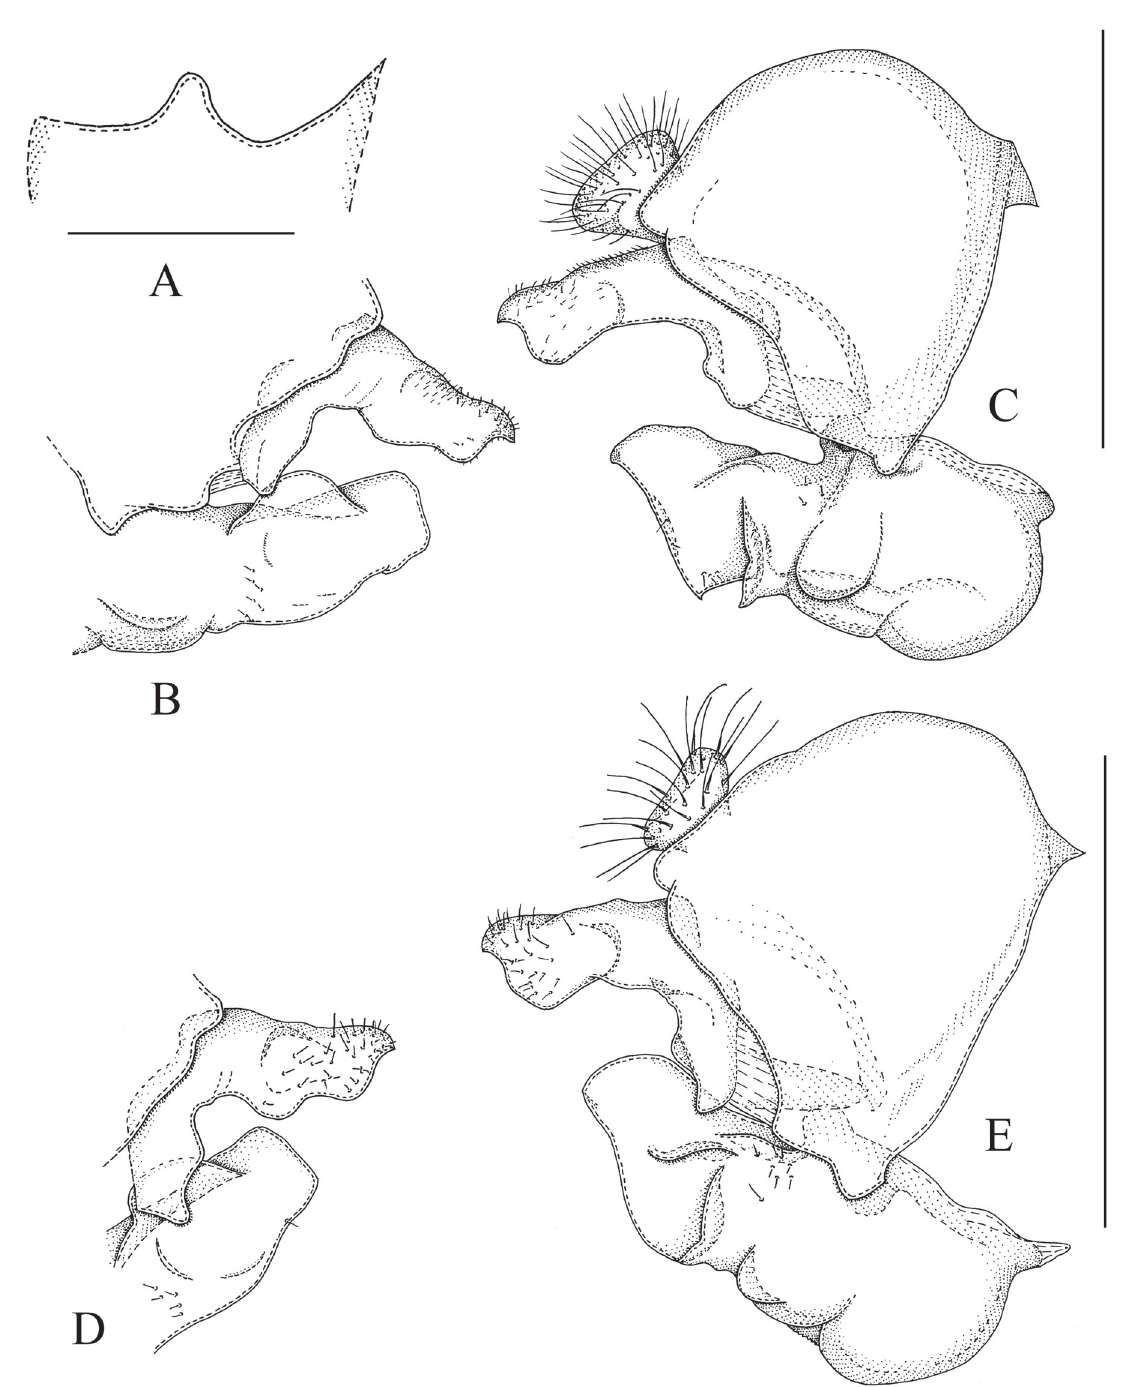
Fig. 9. Sphegina (Asiospheg ina) apicalis Shiraki, 1930, ♂ , A–C from Meifeng, D–E from Puli. A . Posterior part of sternum IV, ventral view. B, D . Posterior part of genitalia, left side, lateral view. C, E . Genitalia, right side, lateral view. Scale bars =